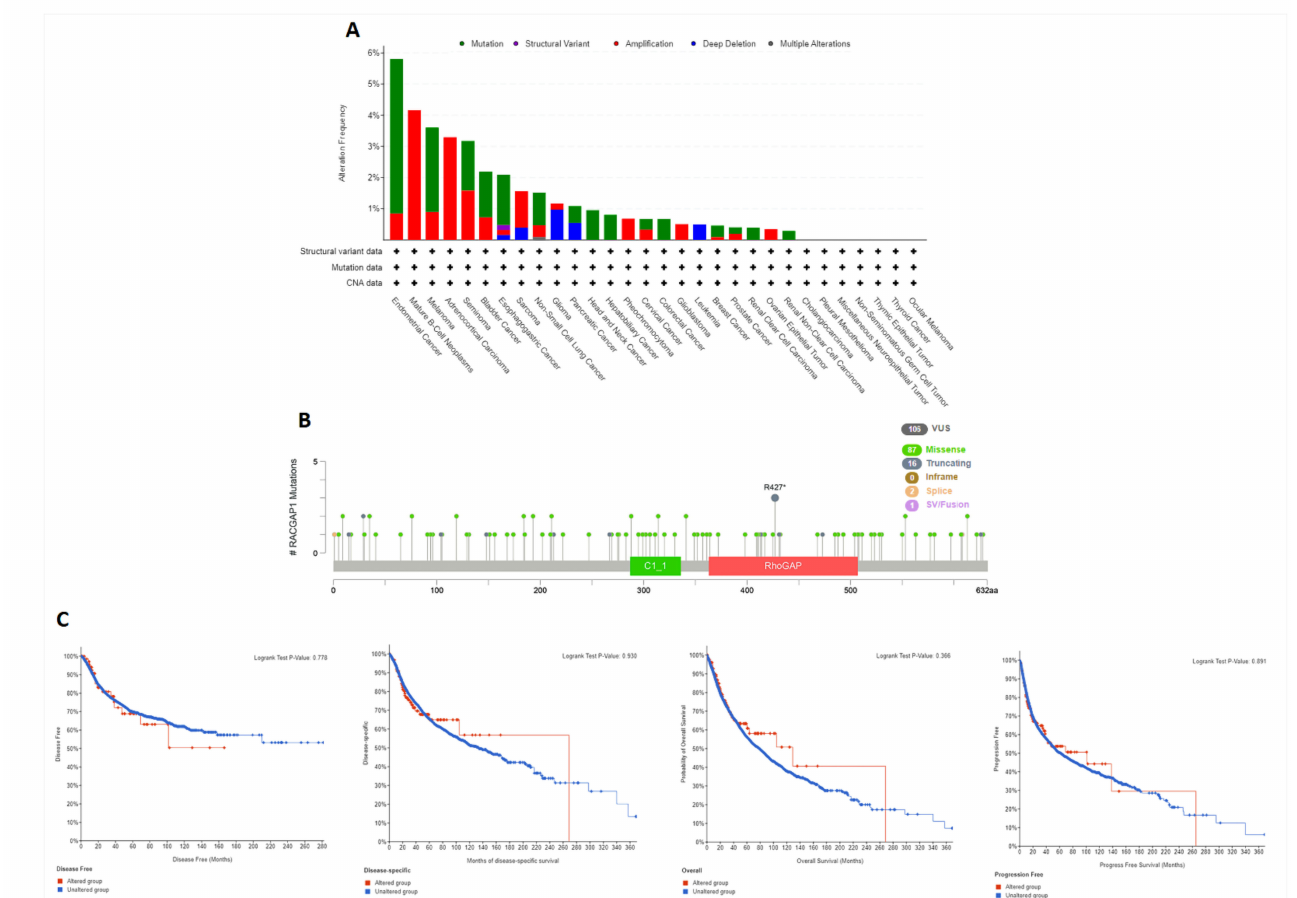
Figure 5. Mutation assessment for RACGAP1 using the cBioPortal tool. ( A ) The alteration frequency with mutation type in a panel of analyzed human cancers; ( B ) a map representation of the sites and types of RACGAP1 mutations; ( C ) assessment of the correlation between RACGAP1 mutation and disease-free, disease-specific, progression-free, and